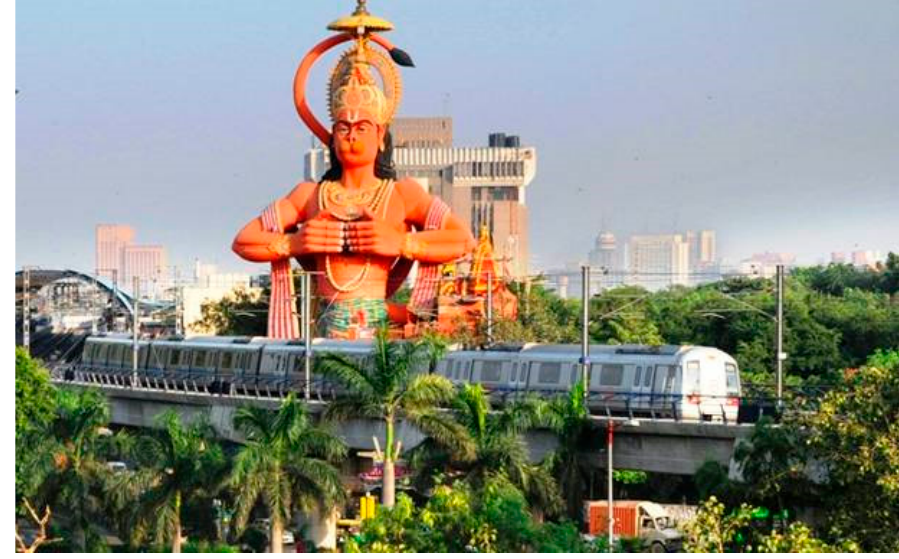
Figure 4. Image of Hanuman, Karol Bagh, Delhi, India.